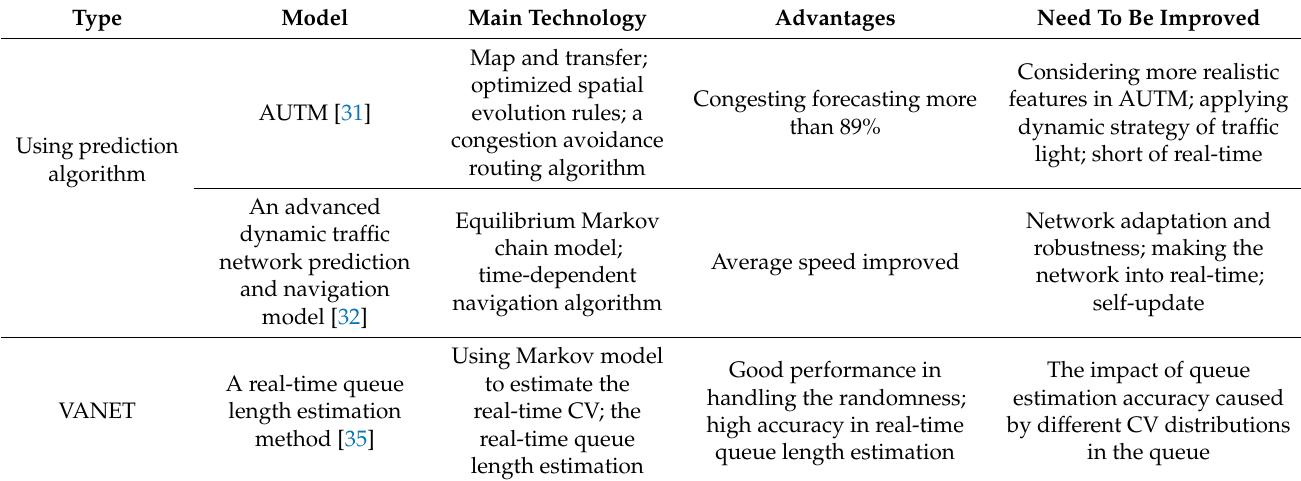
Table 4. Summary of methods in congestion avoidance.